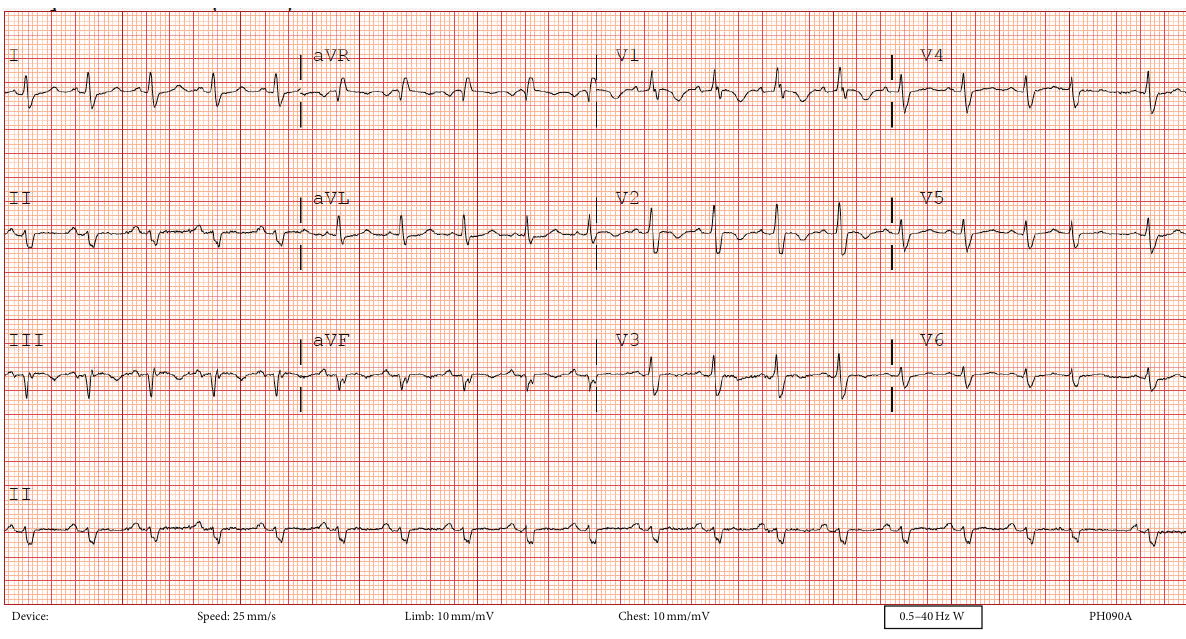
Figure 1: Electrocardiogram at presentation showing sinus tachycardia and S1Q3T3 pattern indicating right ventricular strain.